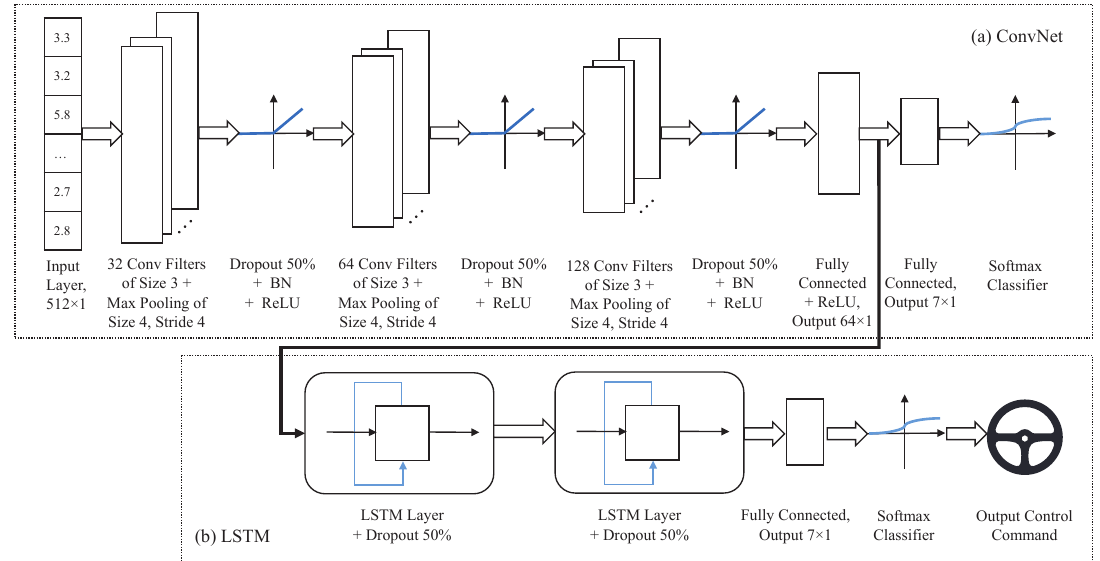
Figure 4. Proposed deep neural network architecture: ( a ) ConvNet includes three convolutional layers, each followed by a max pooling layer with 20% dropout during training and batch normalization (BN). After flattening the final convolutional layer, a fully connected layer that produces 64 × 1 features is then connected to the output layer, which generate one out of seven classes. The 64 × 1 features are fed into ( b ) LSTM: 2 layers of LSTM are stacked together with 50% dropout and 200 hidden states each, and then the output is directly mapped to the steering of the robot. Training is performed in two stages: firstly the ConvNet is trained; then parameters for this ConvNet are saved and frozen so that they consistently produce 64 × 1 features to be fed into the LSTM; then only the LSTM parameters are updated in next stages of